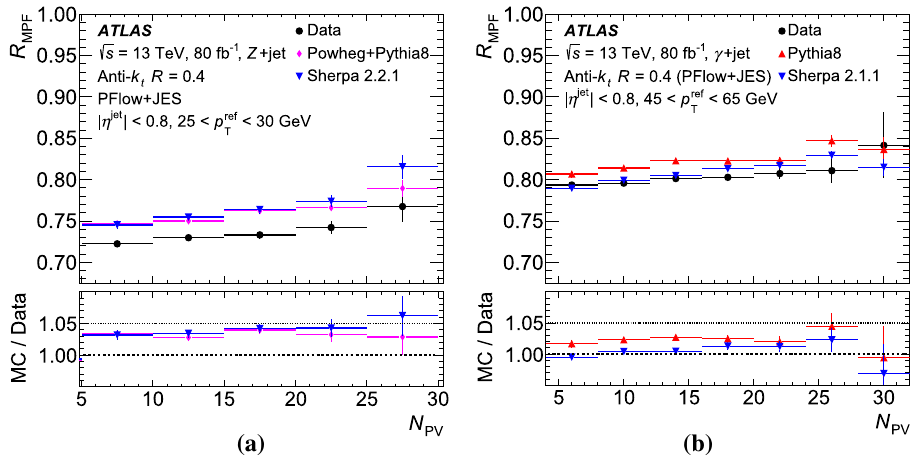
Fig. 17 Average PFlow MPF jet response as a function of N PV for a are combined to reduce statistical fluctuations. The black points cor- Z +jet events with reference p T derived from the reconstructed Z boson respond to 2015–2017 data while the pink and blue points correspond < 30 GeV and for b γ +jetevents withrefer- to Monte Carlo samples from two different generators. The error bars in the range 25 GeV < p ref T < 65 GeV. reflect the statistical uncertainties. The ratio of MC simulation to data ence p T defined from thephoton inthe range 45 GeV < p ref T for both generators is shown in the bottom panel For the Z +jet analysis, results from the Z → ee and Z → μμ channels